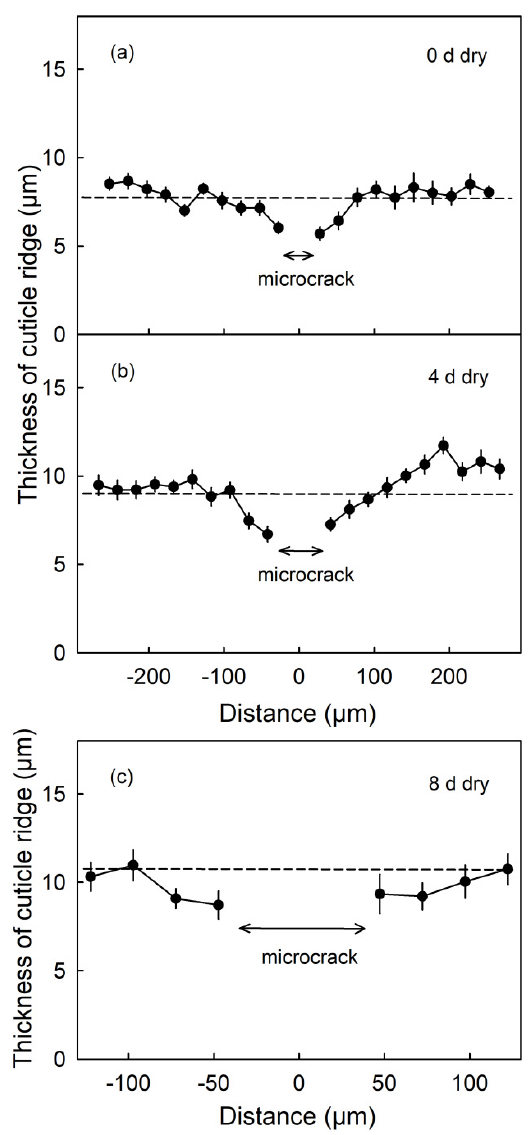
Figure 9. Thickness of the cuticle above the anticlinal cell walls (ridge) as affected by the distance from a moisture induced microcrack. Microcracks were induced by 12 d of moisture exposure. Thickness was measured on cross-sections of the fruit skin prepared from fruit sampled on the day of termination of moisture exposure (0 d) ( a ) and 4 d ( b ) and 8 d ( c ) after moisture termination (during Phase II). The distance ‘0’ represents the center of the microcrack. Thickness was measured in both directions from the microcrack. The dashed line is the grand mean thickness of all cuticle ridges within the micrograph. The arrows indicate the mean width of the microcrack. Data represent means ± SE of 14 to 19 microcracks on a total of six fruits.